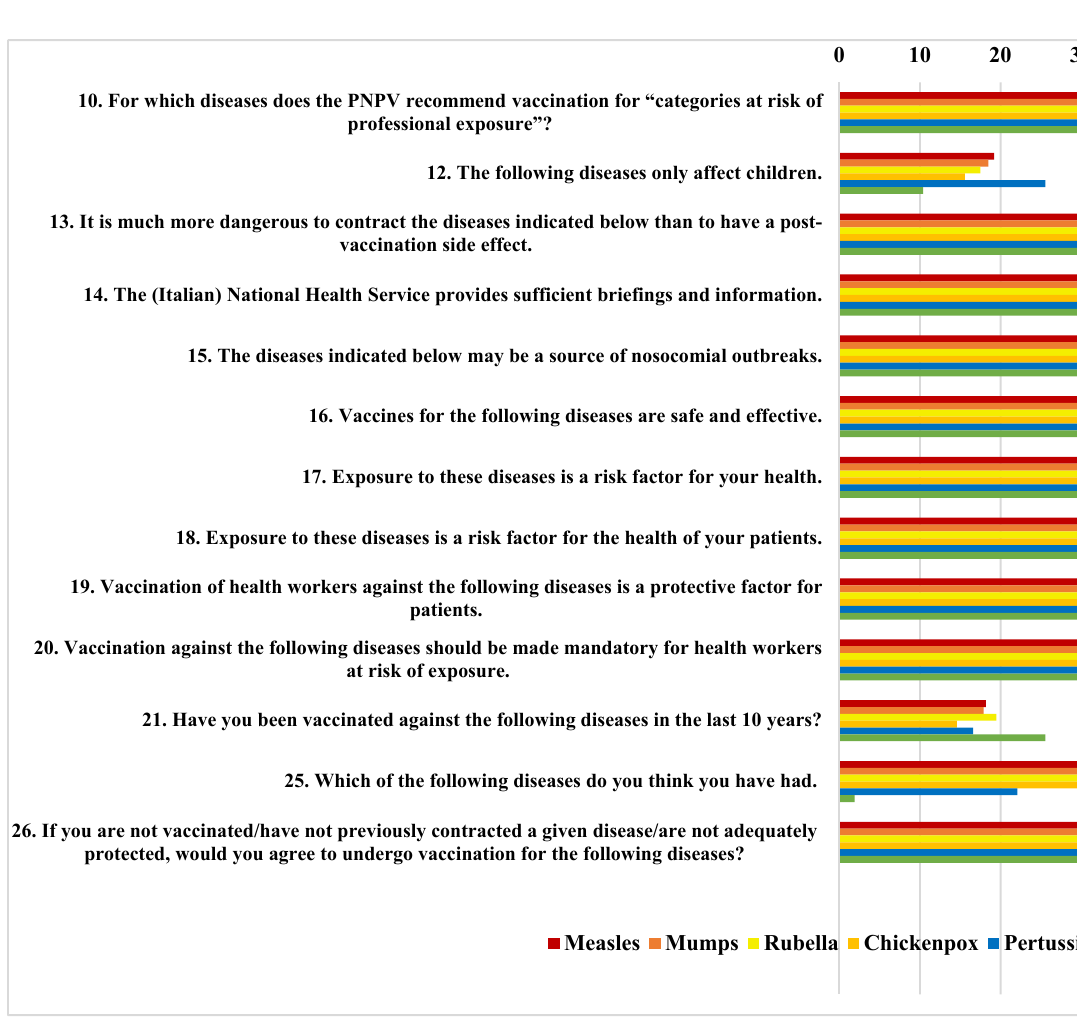
Figure 1. Descriptive analysis: percentages of positive responses (agree, yes) to the questionnaire.